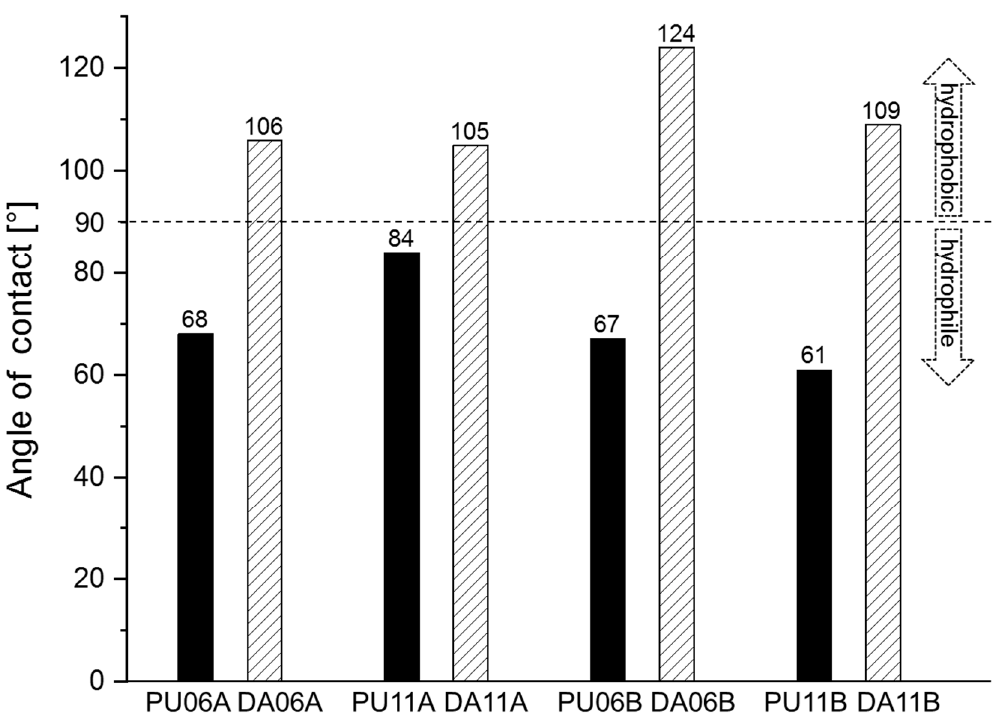
Figure 5. Contact angles of PUs and DA products.